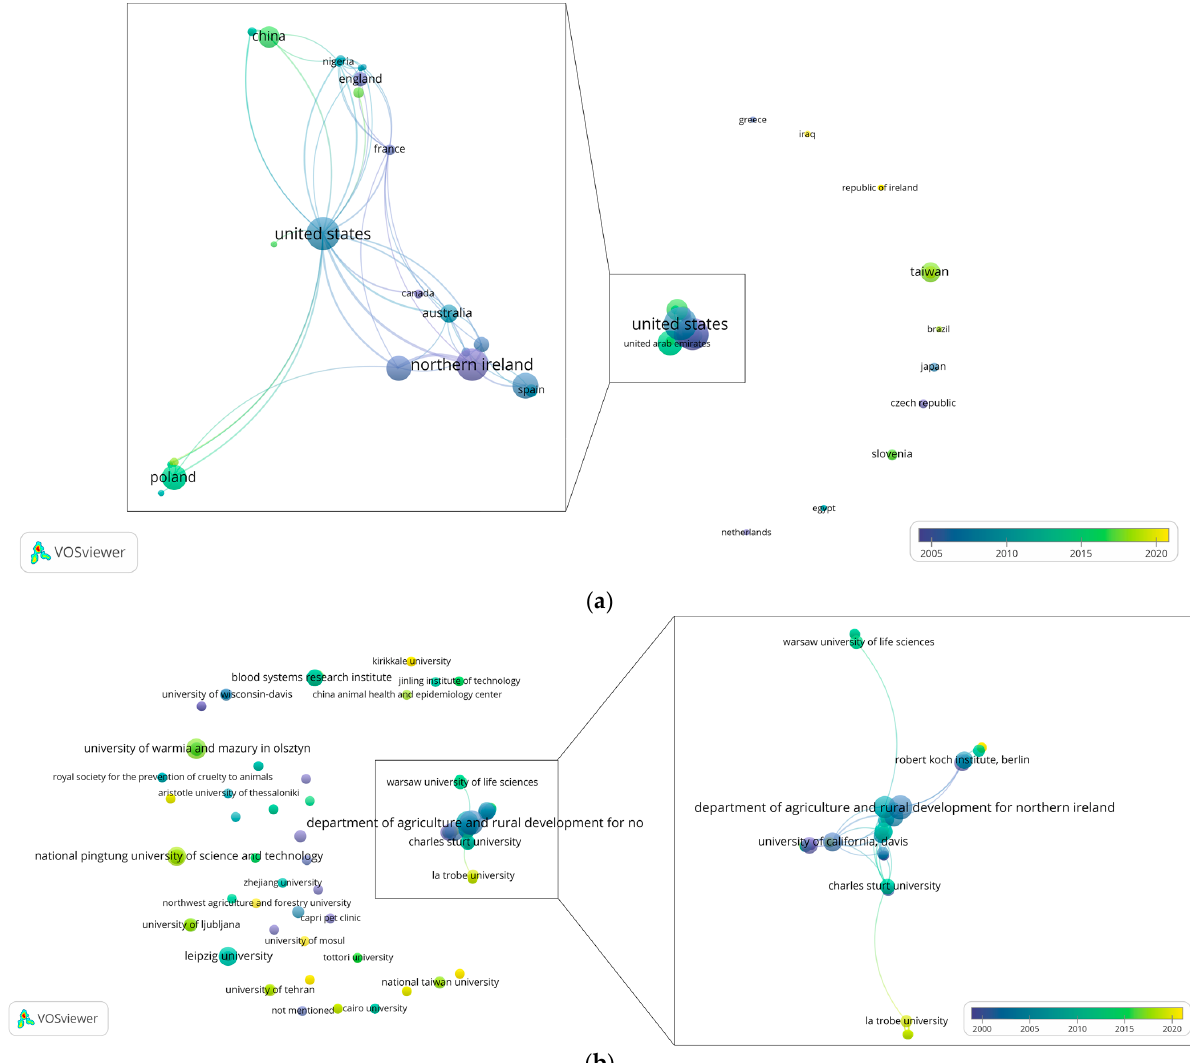
Figure 3. PiCV research collaboration maps among ( a ) countries and ( b ) institutions scaled by number of documents produced and colored by average publication